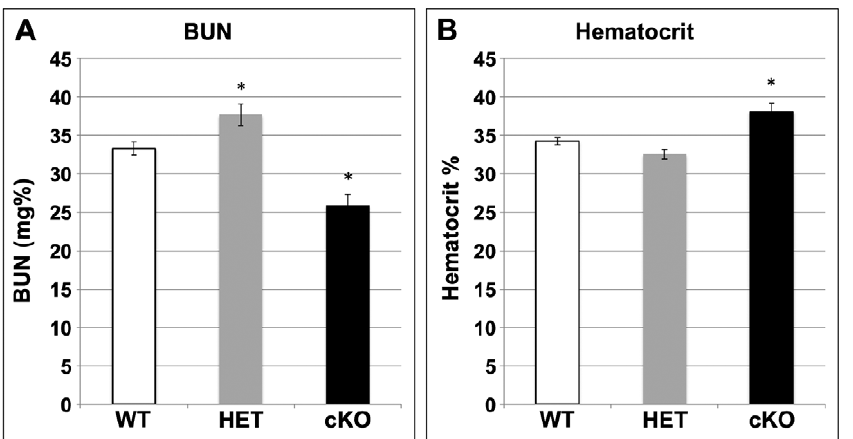
Figure 4. Effect of MFN2 conditional knockout on hematocrit and blood urea nitrogen (BUN). Hematocrit and BUN levels four days after birth. ( A ) Hematocrit was minimally increased in MFN2 cKO animals suggesting that they were volume depleted ( B ) BUN was slightly decreased in